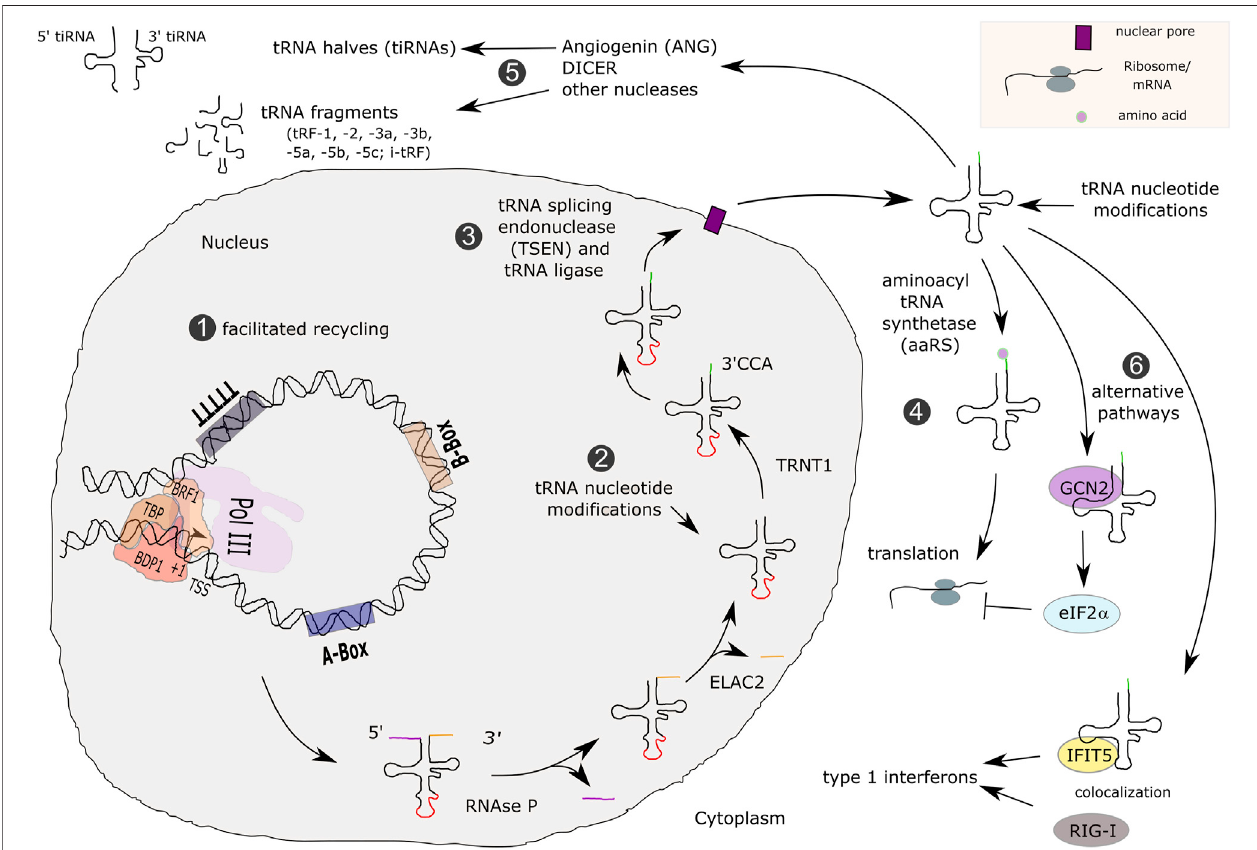
FIGURE 7 | Transcription, maturation and functions of tRNAs. Type 2 promoter tRNA genes are transcribed by Pol III, possibly involving the facilitated recycling pathway, which allows transcription reinitiation in the absence of TFIIIC (1). Primary tRNAs contain 5 ′ leader and 3 ′ trailer sequences (colored lines) and a few human tRNAs contain introns (red line). tRNAs are processed by RNAse P, ELAC2 and TRNT1 (2), as well as spliced in the nucleus (3). Mature tRNAs are exported to the cytoplasm and loaded with amino acids for participating in translation (4). Other functions for tRNAs that were described involve enzymatic processing for yielding tRNA fragments (tRFs) or tRNA halves (tiRNAs) (5). In addition, they can enter alternative functional pathways